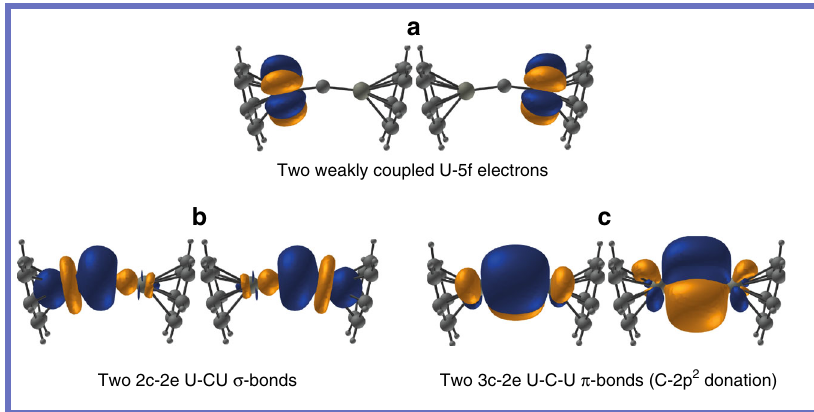
Fig. 2 Natural Localized Molecular Orbitals (NLMOs) of sandwiched UCU. The UCU@(C 7 H 7 ) 2 molecule formally consists of a (UCU) 6 + unit between two aromatic (C 7 H 7 ) 3 − rings. Spin – orbit coupled multi-reference all-electron relativistic wavefunction calculations (state-averaged CASSCF) were analyzed with the NBO program [S27]. The contour values of the NLMOs generated thereby are ±0.042 √ (e/Å 3 ). a The two 1-center U-5f 1 -type NLMOs, each occupied by one electron. b The U – C (left) and C – U(right) 2-center 2-electron (2c2e) σ -pair NLMOs, each consisting of 67% C-2sp 1 , 31% U-5f ½ 6d and 2% tail-contribution from the other U. c The vertical π -type and the in-plane dominantly π -type U – C – U 3-center 2-electron (3c2e) NLMOs of 65% C-2p s and 17% of each of the two U-5f ½ 6d